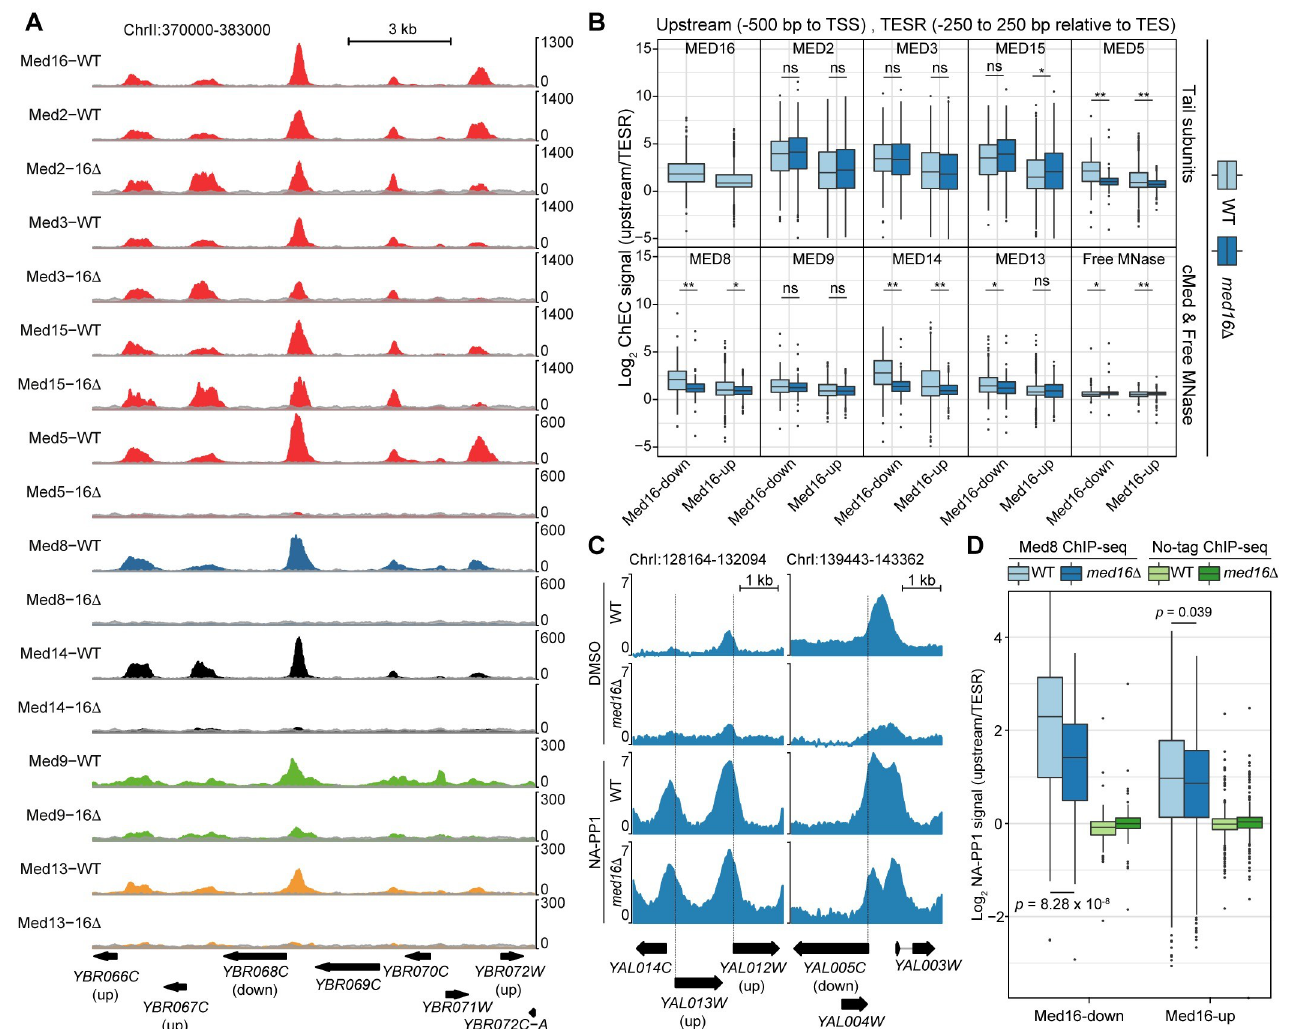
Fig 2. Effects of tail separation on Mediator association with the genome. (A) Tracks of Mediator tail (Med2, Med3, Med5, Med15, Med16), middle (Med9), head (Med8), kinase (Med13), and scaffold (Med14) ChEC-seq signal at a representative region of the yeast genome from WT and med16 Δ cells. Free MNase signal from the appropriate strain is overlaid (grey) on each track for comparison. (B) Boxplots of log 2 upstream/TESR Mediator and free MNase ChEC-seq signal from the WT and med16 Δ strains for Med16-down and Med16-up genes. Statistical differences between groups were assessed by Wilcoxon rank-sum test: ns indicates no significant difference, � indicates p < 0.01, and �� indicates p < 0.001. (C) Tracks of log 2 Med8/no-tag ChIP-seq signal from the WT kin28as and med16 Δ kin28as strains treated with DMSO or NA-PP1. (D) Boxplots of log 2 upstream/TESR Med8 and no-tag ChIP-seq signal from the WT kin28as and med16 Δ kin28as strains treated with NA-PP1 for Med16-down and Med16-up genes. Statistical differences between groups were assessed by Wilcoxon rank-sum test.